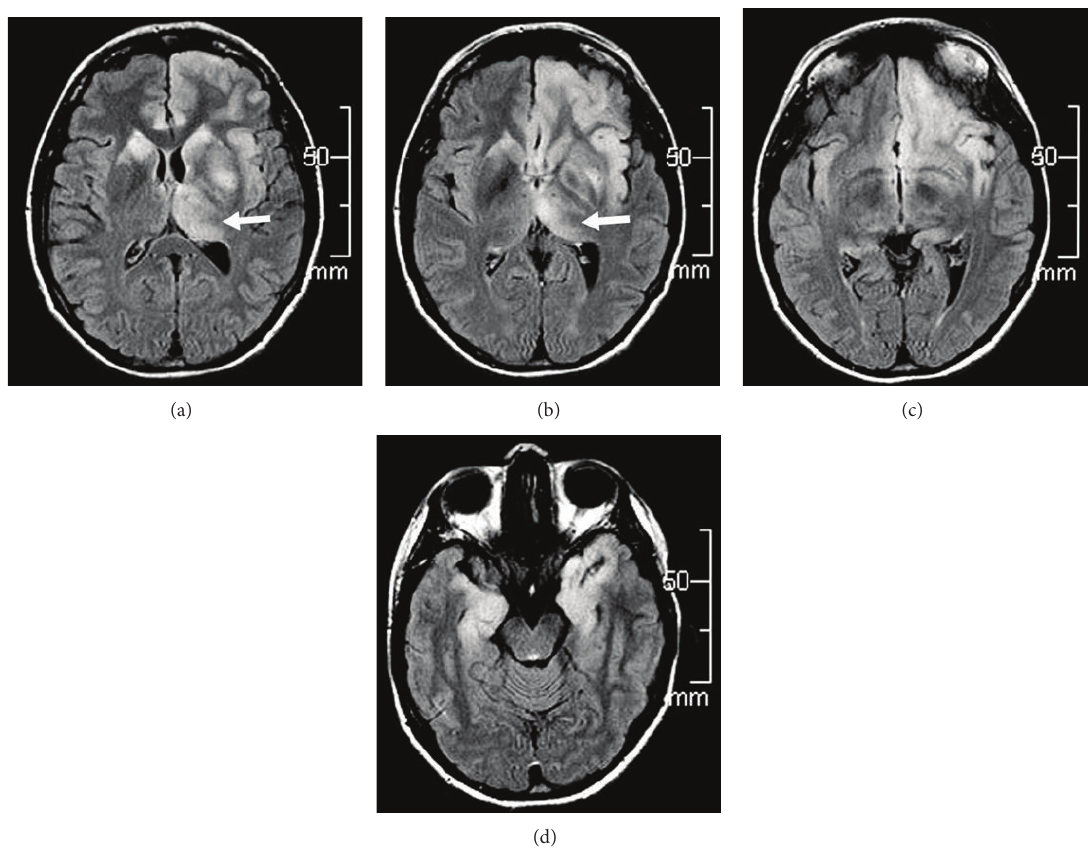
Figure 18: A patient with gliomatosis cerebri involving the left thalamus (arrows, a and b), the bilateral basal ganglia (a and b), the left frontal lobe (a, b, and c), and both temporal lobes (d), seen as hyperintensity on FLAIR